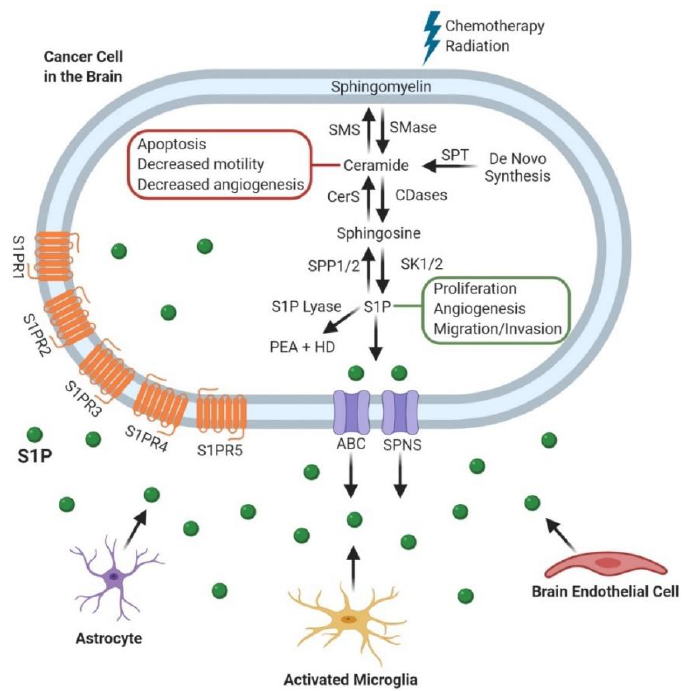
Figure 1. Sphingolipid Metabolism and its role in Cancer Progression. After chemotherapy and radiation, sphingomyelin is broken down into ceramide which has roles in blocking cancer progression. Cancer cells can convert ceramide to sphingosine-1-phosphate (S1P), which is transported out of the cell by either ATP-binding cassette (ABC) or spinster (SPNS) transporters [36,37]. S1P then exerts its pro-tumor effects through both intracellular and extracellular mechanisms. Alternatively, S1P can be degraded by S1P lyase to produce Phosphatidylethanolamine (PEA) and Hexadecenal (HD) [6,38]. These processes also occur in the other cell populations within the brain tumor microenvironment including astrocytes, microglia, and endothelial cells.Sphingomyelin Synthase (SMS); Ceramide synthase (CerS); Sphingosine phosphate phosphatase 1/2 (SPP1/2); Sphingomyelinase (SMase); Ceramidase (CDase); Sphingosine kinase 1 / 2 (SK1 / 2); Serine palmitoyltransferase (SPT); Sphingosine-1-phosphate (S1P); Phosphatidylethanolamine (PEA); Hexadecenal (HD); ATP-binding cassette (ABC); Spinster